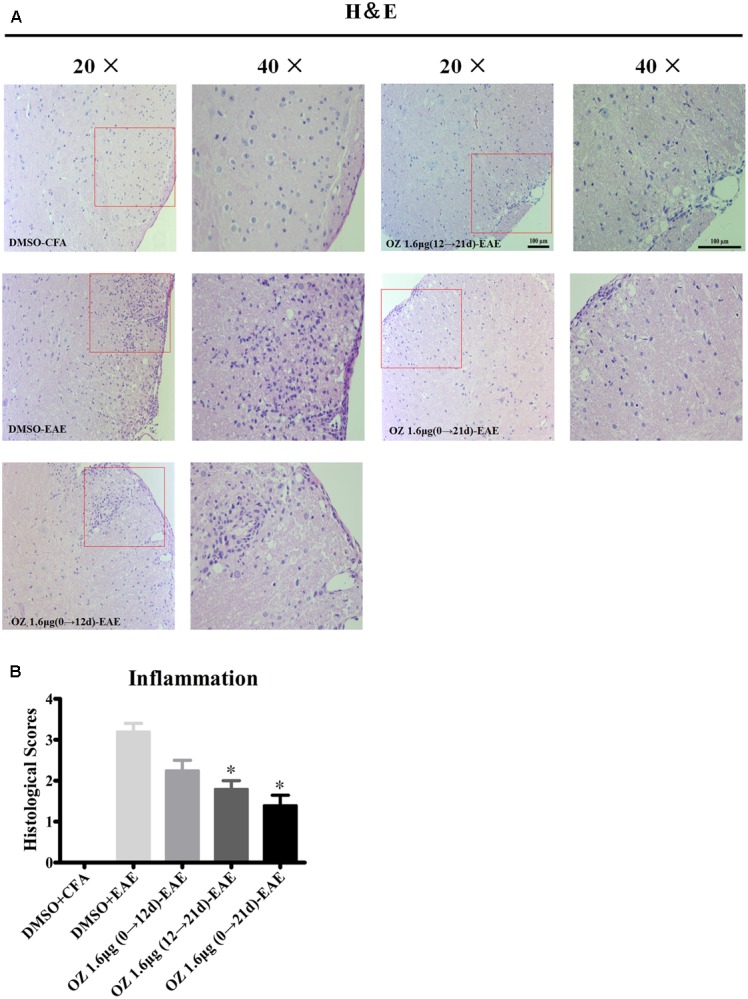
The effect of 5Z-7-oxozeaenol treatment on lymphocyte infiltration of spinal cords from EAE mice. H&E staining was used to evaluate inflammation in the lumbar intumescence spinal cord in each group at 21 days post-immunization with MOG35-55. Scores were determined by a semi-quantitative method. (A) Representative H&E staining of spinal cord sections. (B) Quantification of inflammation in the spinal cord. Each group included five mice, except for the 5Z-7-oxozeaenol 1.6 μg (0→12 d)-EAE group, which only had four mice because one died. ∗Adjusted P < 0.017 versus DMSO-EAE group (Mann–Whitney U-test). Data are means ± SEM. OZ, 5Z-7-oxozeaenol. Scale bar = 100 μm.